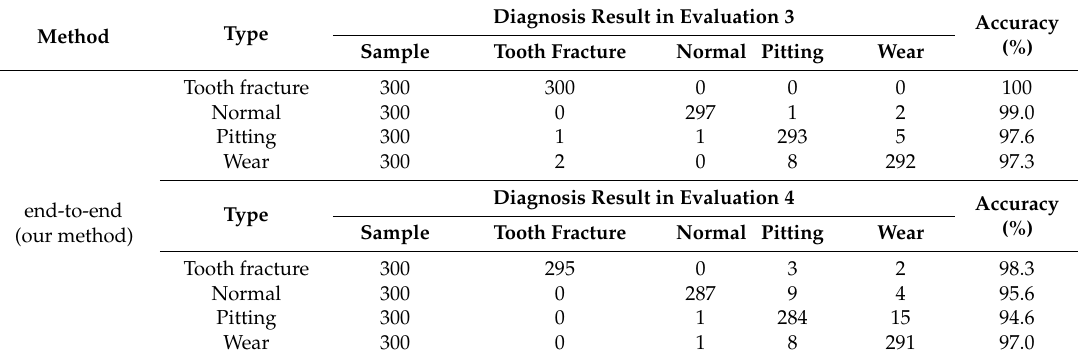
Table 4. Diagnosis result of our method in Evaluation 3 and Evaluation